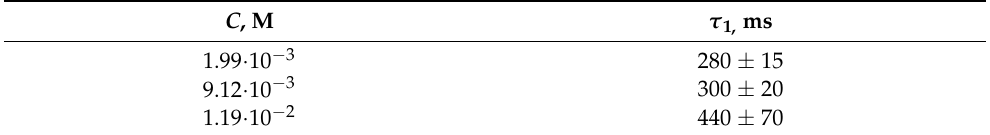
Figure 11. The dependences of the relative parts p 1 of molecules of compound XI on the diffusion time t d at various concentrations. The concentrations indicate in the insertion. Table 7. The values of the lifetime of the molecules of compound XI in the RBC membrane at various concentrations.